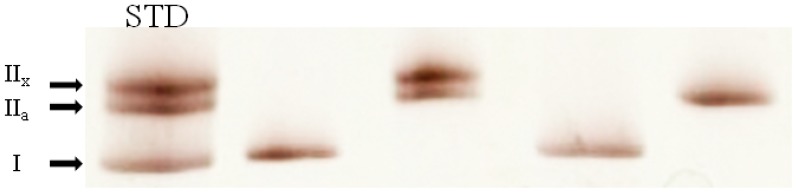
MHC isoform determination in single muscle fibers using silver staining.The figure is a representative example of an 8% silver stained SDS gel. Samples from single fibers containing (from left to right) the type I, IIa/IIx, I and IIa MHC isoform, respectively. STD, standard samples containing MHC I, IIa, and IIx isoforms.